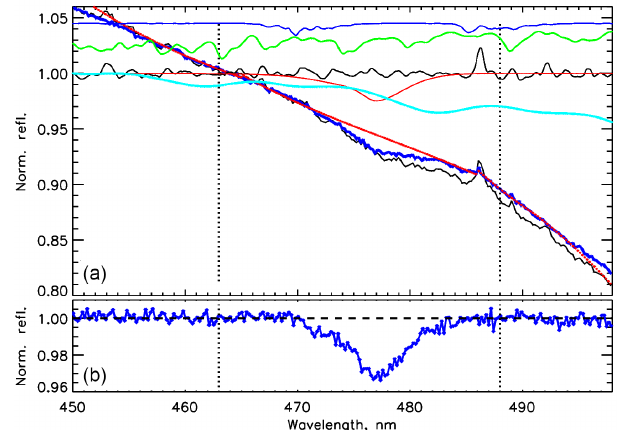
Figure 4. Similar to Fig. 3 but for the open-water nearly cloud-free ( f < 0 . 05) region of the Indian Ocean (54.02 ◦ S, 106.91 ◦ E, OMI orbit 7791, 1 January 2006). The thick blue line follows these re- flectances after removal of the Ring patterns and the trace-gas (O 3 , NO 2 , and H 2 O) absorption. The red line shows the piecewise fit to the blue line.